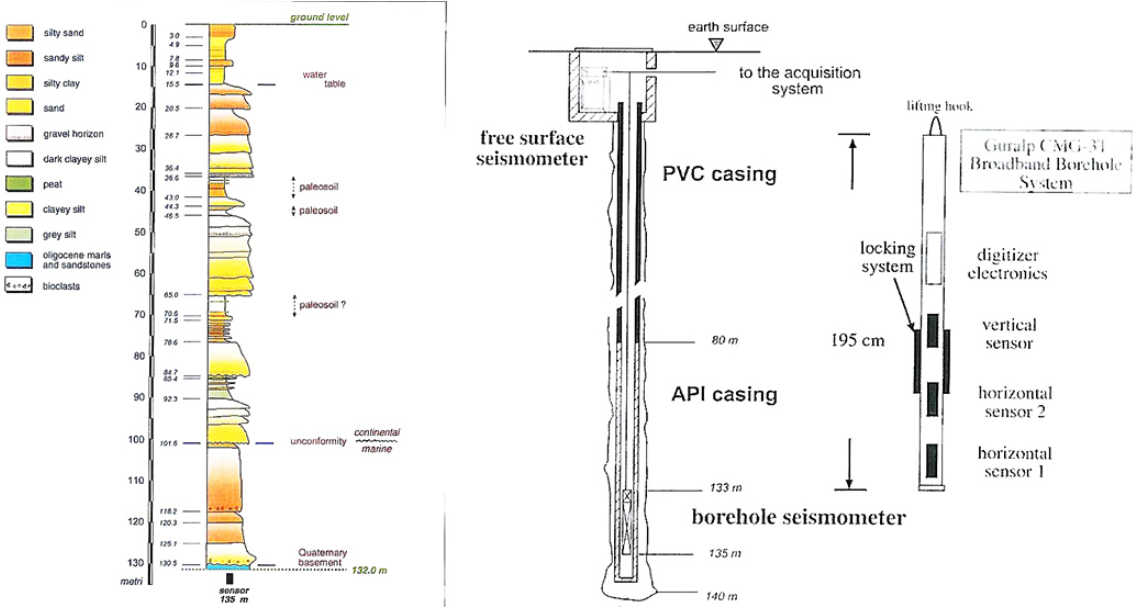
Figure 2. Stratigraphic log of the borehole site (left) and schematic of the borehole system and its installation (right) from Cocco et al. (2001).